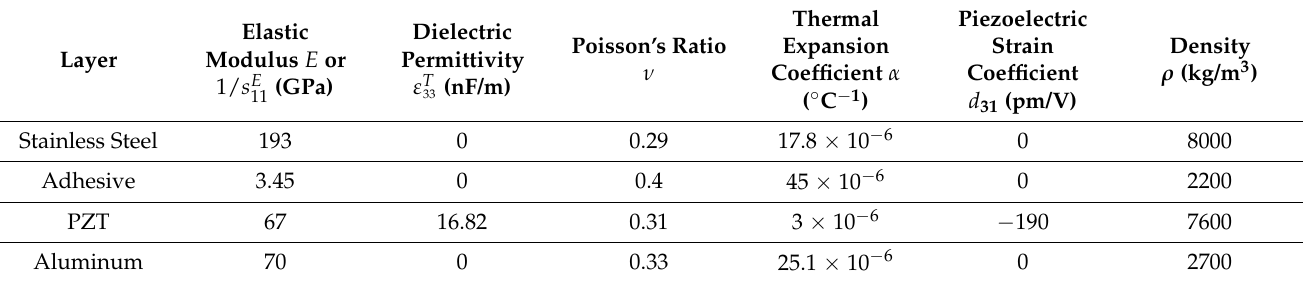
Table 2. Properties of THUNDER